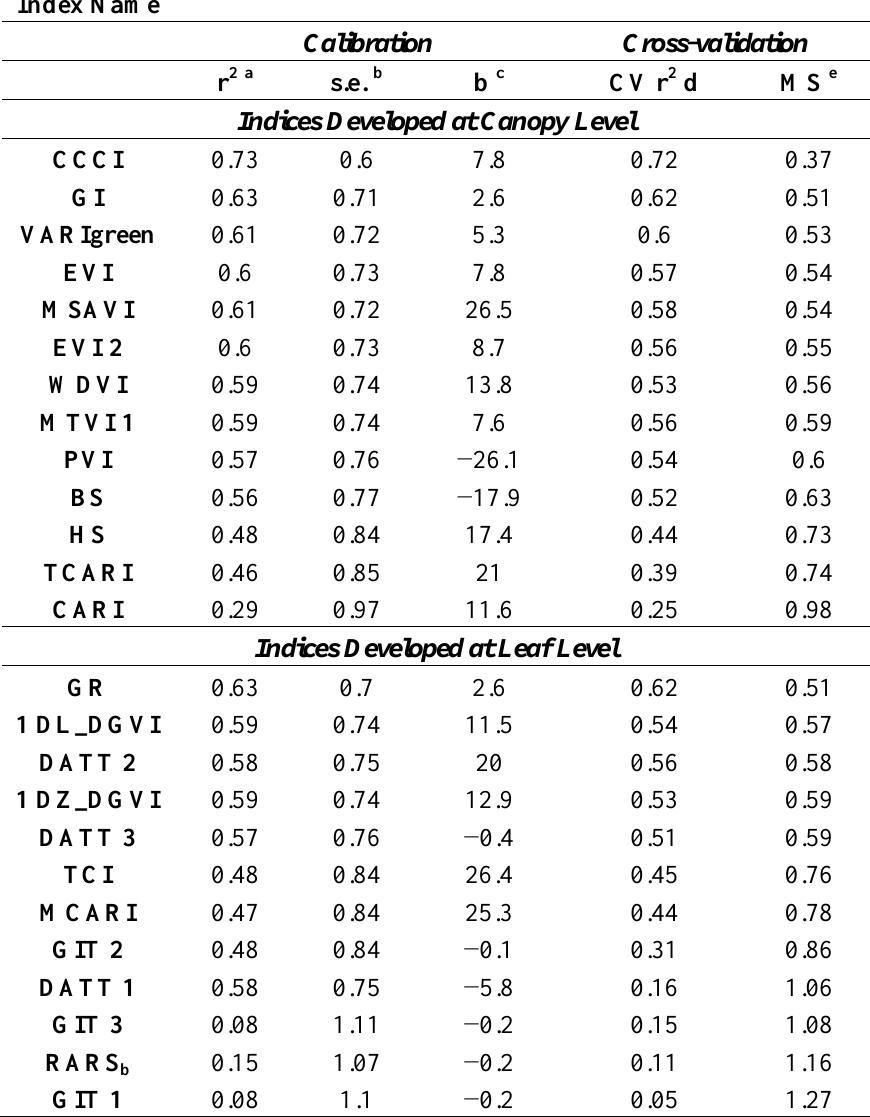
Table 5. Calibration and validation of the estimation of plant N content (g∙m −2 ) by vegetation indices for the pooled Australian and Italian site (AUS + ITA) at Z30. Regressions were significant at p < 0.001. Indices are ordered by the coefficient of determination of the cross validation (CV r 2